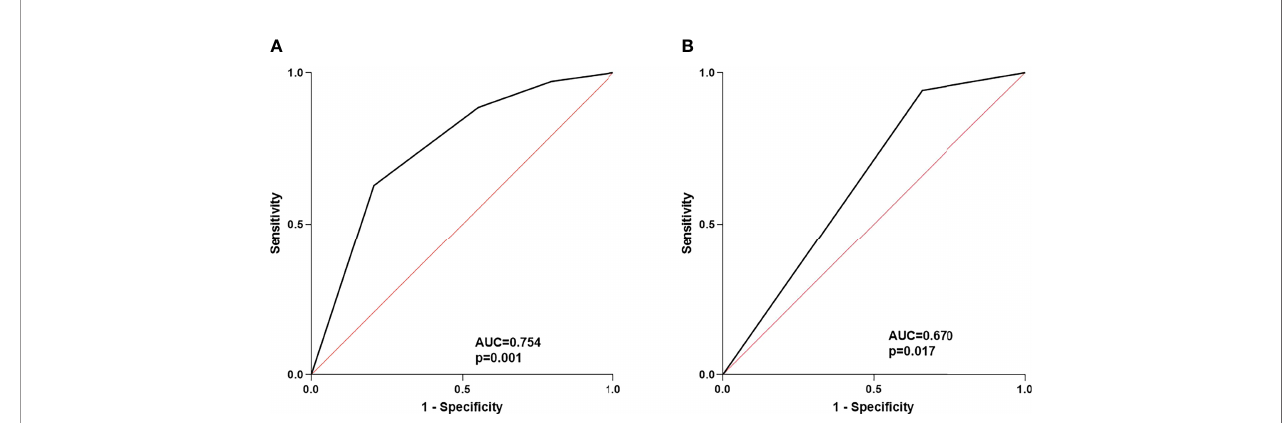
FIGURE 4 | (A) ROC curve of the risk factors for any grade of irAEs; (B) ROC curve of risk factors for 3/4 grade